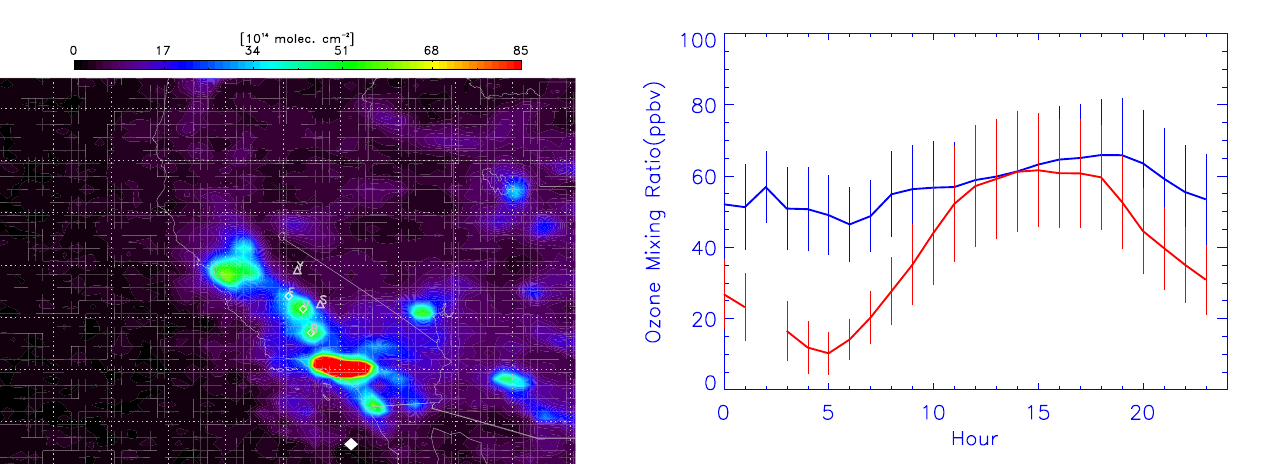
Fig. 8. Climatological (2005–2008) tropospheric NO 2 columns for the month of June along the west coast of the USA. The location of the cities along the San Joaquin valley are shown as diamonds (F – Fresno, V – Visalia and B – Bakersfield) and the national parks are shown as triangles (Y – Yosemite and S – Sequoia).